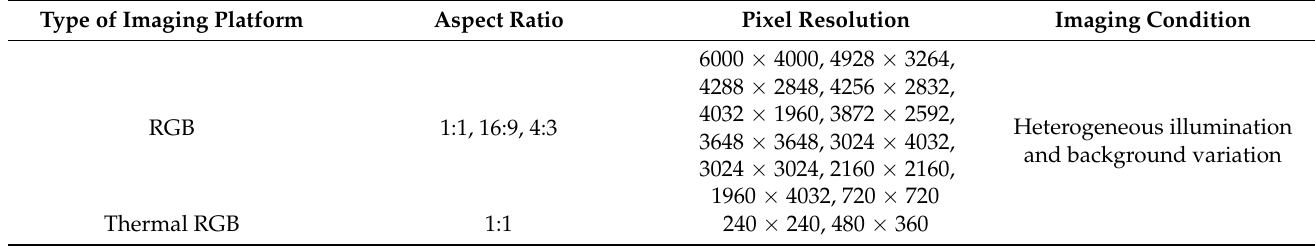
Table 1. Specification of collected images.